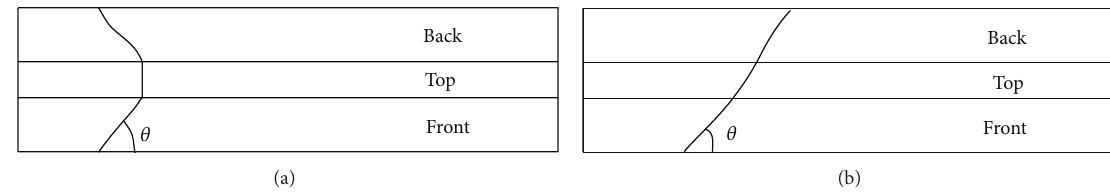
Figure 1: (a) Shear and (b) torsional cracking